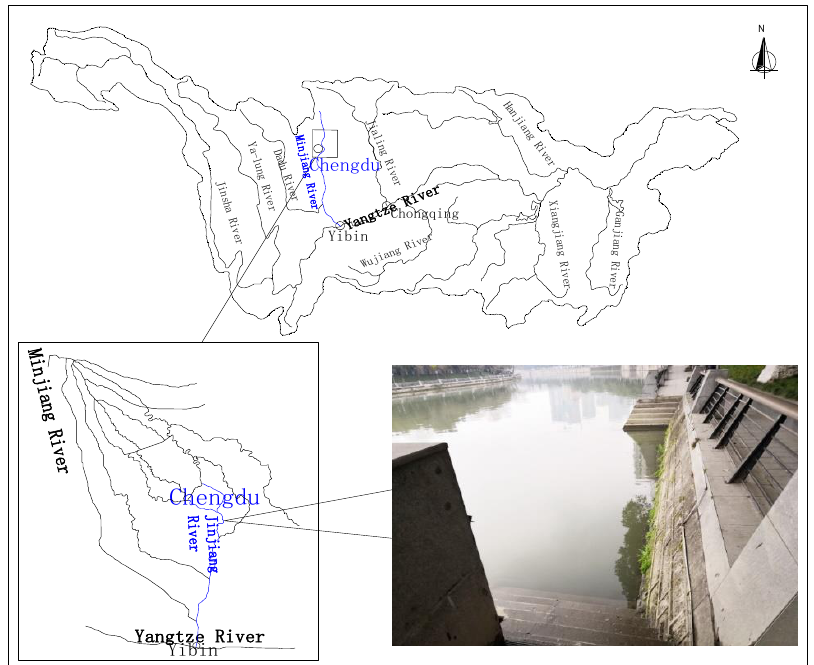
Figure 2. Location of the sampling site.